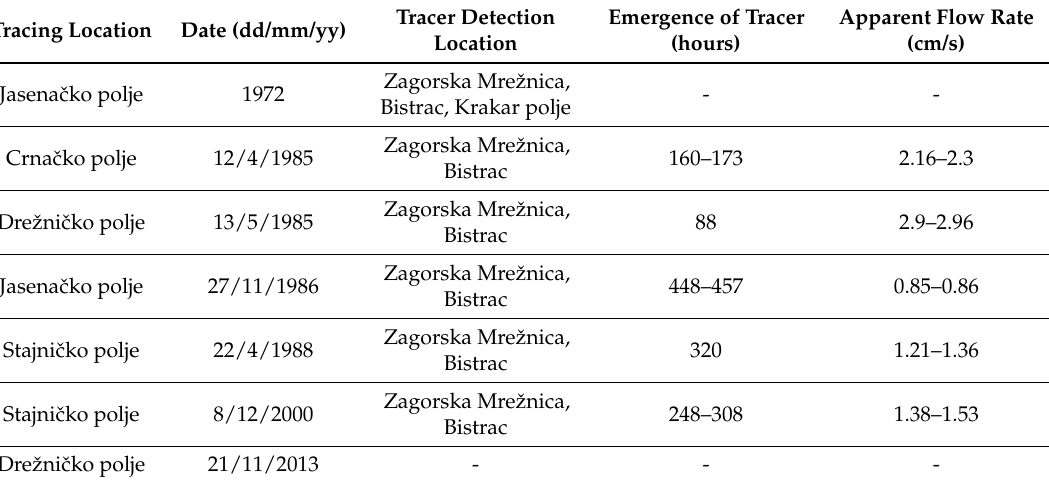
Table 2. Underground waterflow tracing results in Zagorska Mrežnica